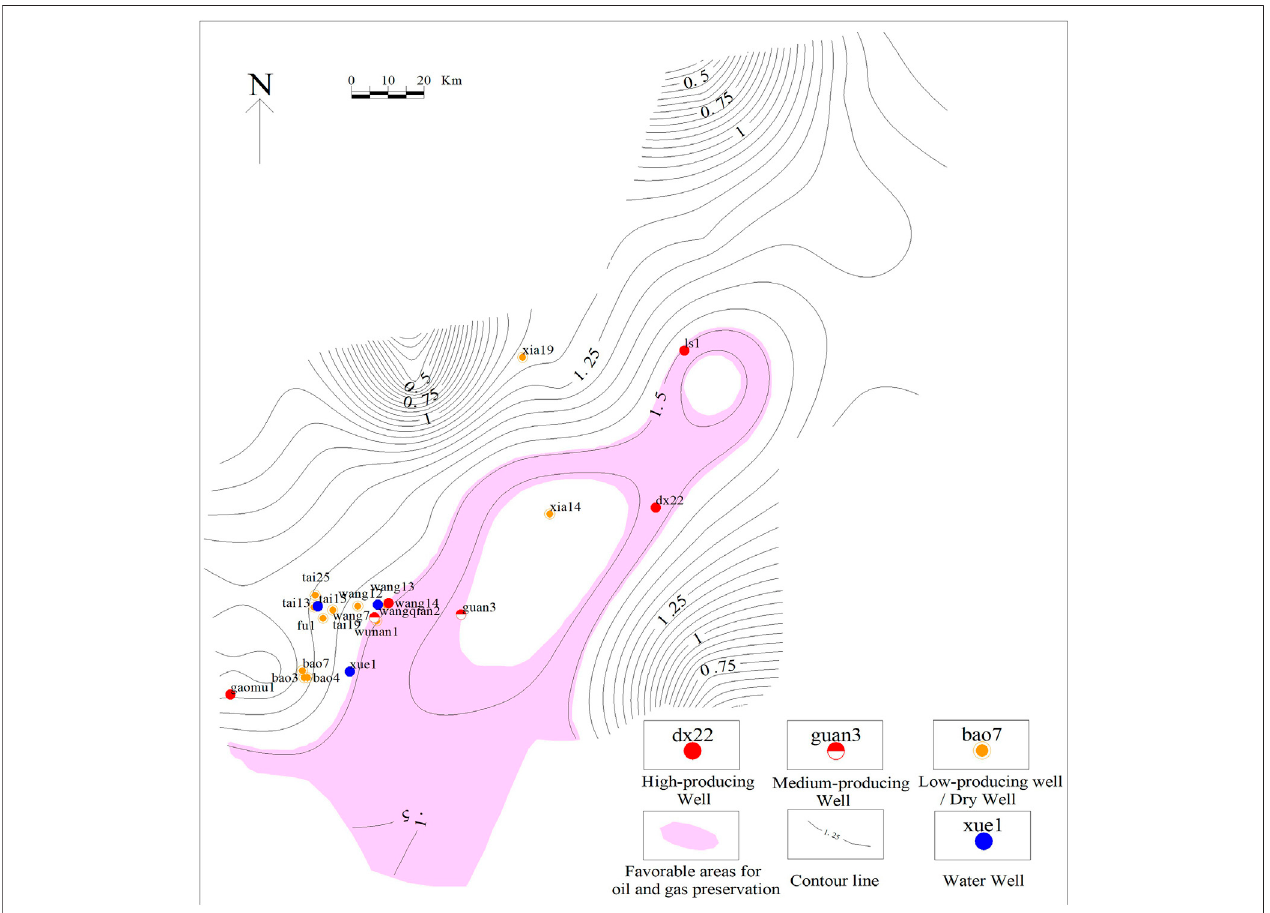
FIGURE 9 | Relatively favorable areas for oil and gas preservation in southeast Sichuan (labeled with fractal dimensions of faults).